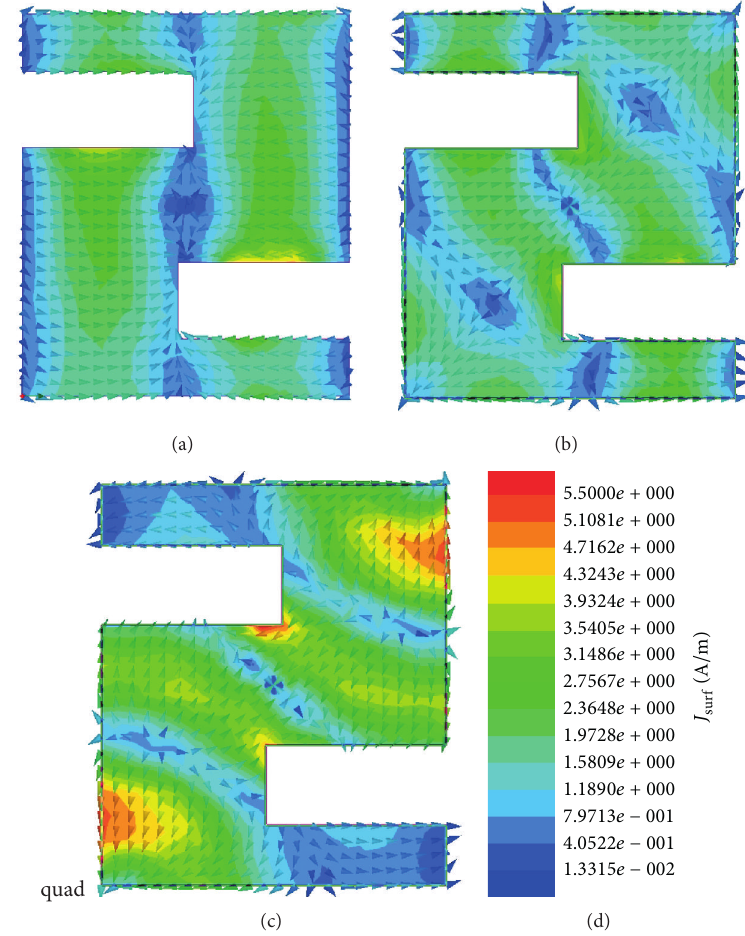
Figure 11: Current distribution at (a) 9.08 GHz, (b) 11.00 GHz, (c) 11.86GHz, and (d) scale.